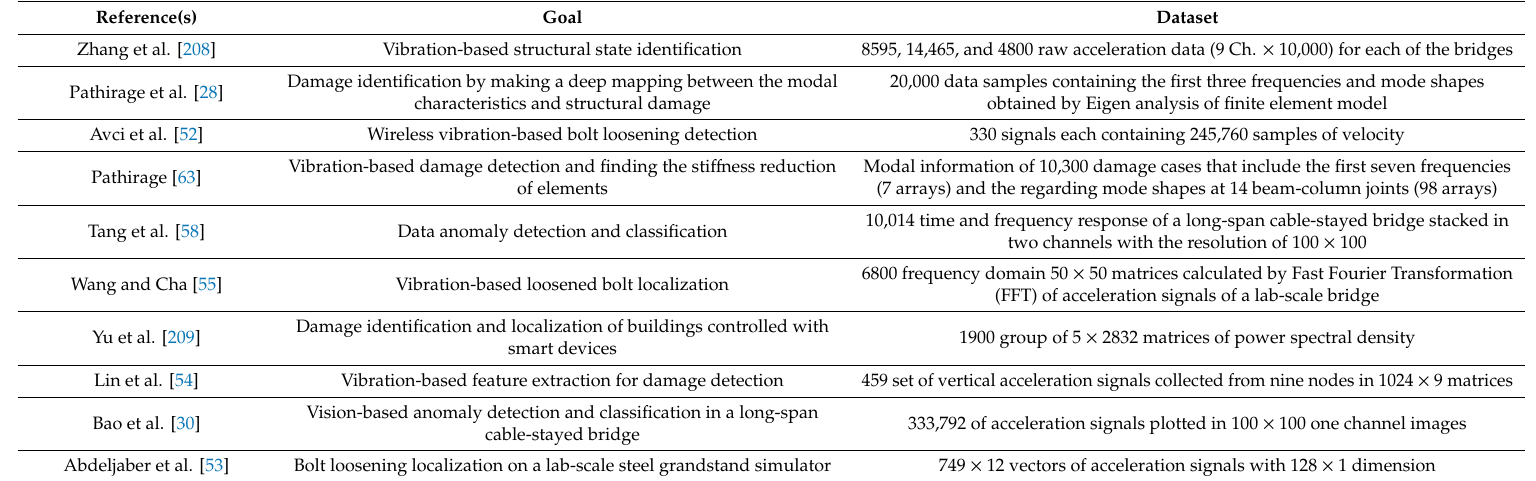
Table 2. Examples of vibration-based datasets for deep learning (DL)-based SHM.